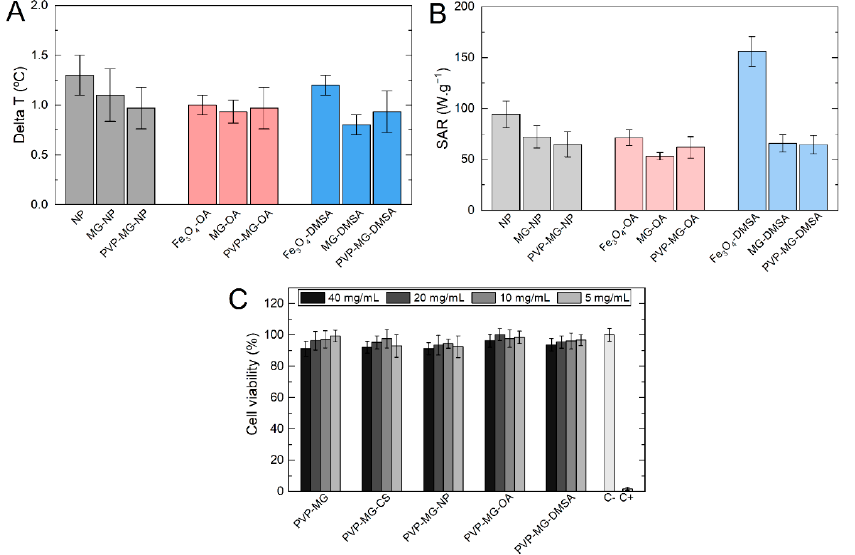
Figure 7. Temperature variation ( A ) and specific absorption ratio (SAR) of PVP membranes with magnetic PNIPAAm microgels incorporated, and the respective microgel and bare Fe 3 O 4 NPs sample ( B ). Experiments were performed during 10 min of exposure to an alternating magnetic field with an intensity of 24 kA·m − 1 and 418.5 kHz. ( C ) Vero cell viability (%) after 48 h of indirect exposure to the produced membranes. Initial concentration (C i ) of 40 mg·mL − 1 with three factor 2 dilutions (20, 10, and 5 mg·mL − 1 ). Data is expressed as average ± standard deviation for five replicas.